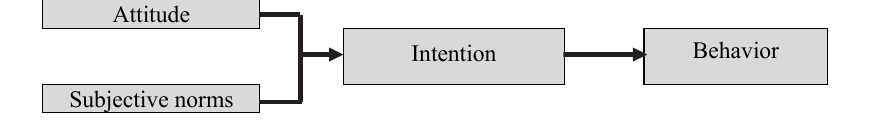
Fig. 1. Attitude Subjective norms Fig. 1. Ajzen and Fishbein Theory of Reasoned Action (Ajzen,